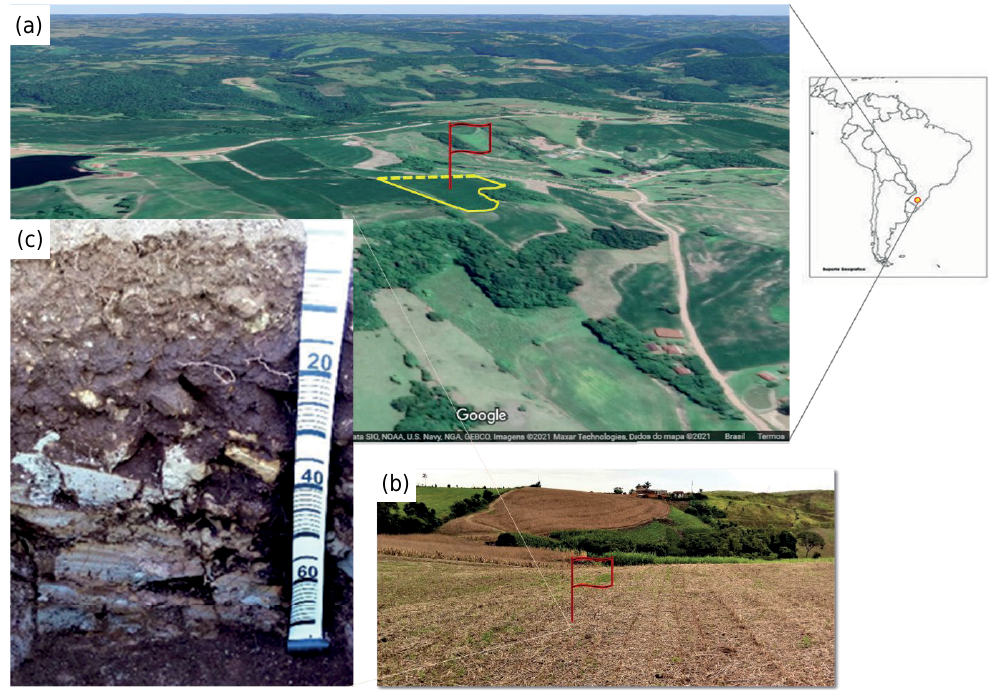
Figure 1. View of the region’s landscape (Google Earth) (a), a characteristic position of the crop area (29° 30’ 20.1” S; -53° 37’ 34.60” W) (b), and the profile of the predominant Entisoil (Typic Udorthents)